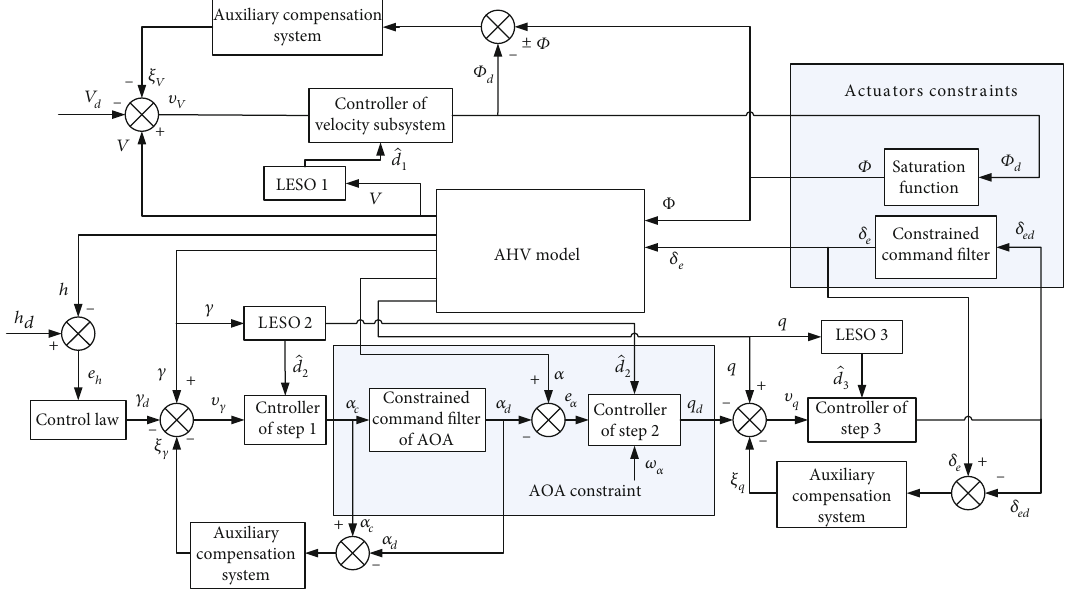
Figure 1: The structure of control scheme presented for